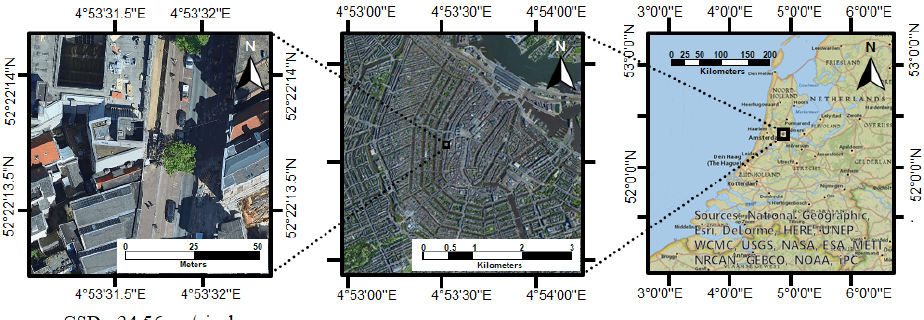
Figure 1. A sample of a remote sensing image with ground sampling distance (GSD) that was obtained using Google